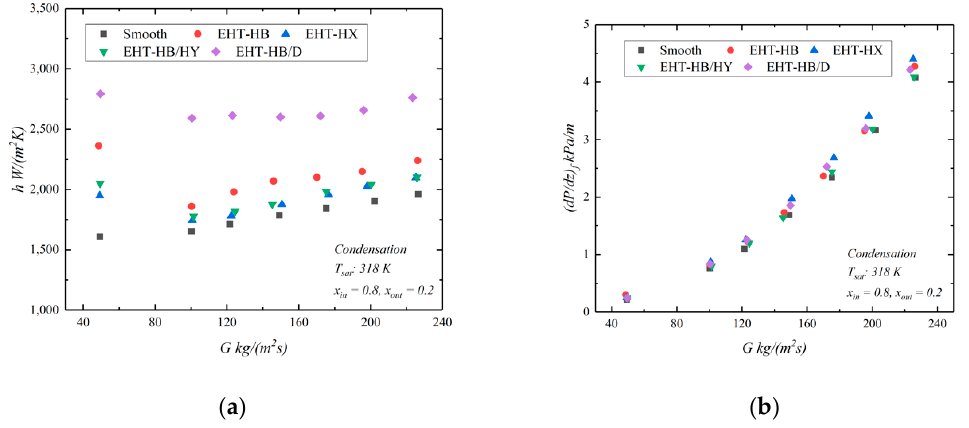
Figure 5. Tubeside condensation performance comparison (using R410A) of heat transfer tubes as a function of mass flux (G) for: ( a ) condensation HTC and ( b ) pressure